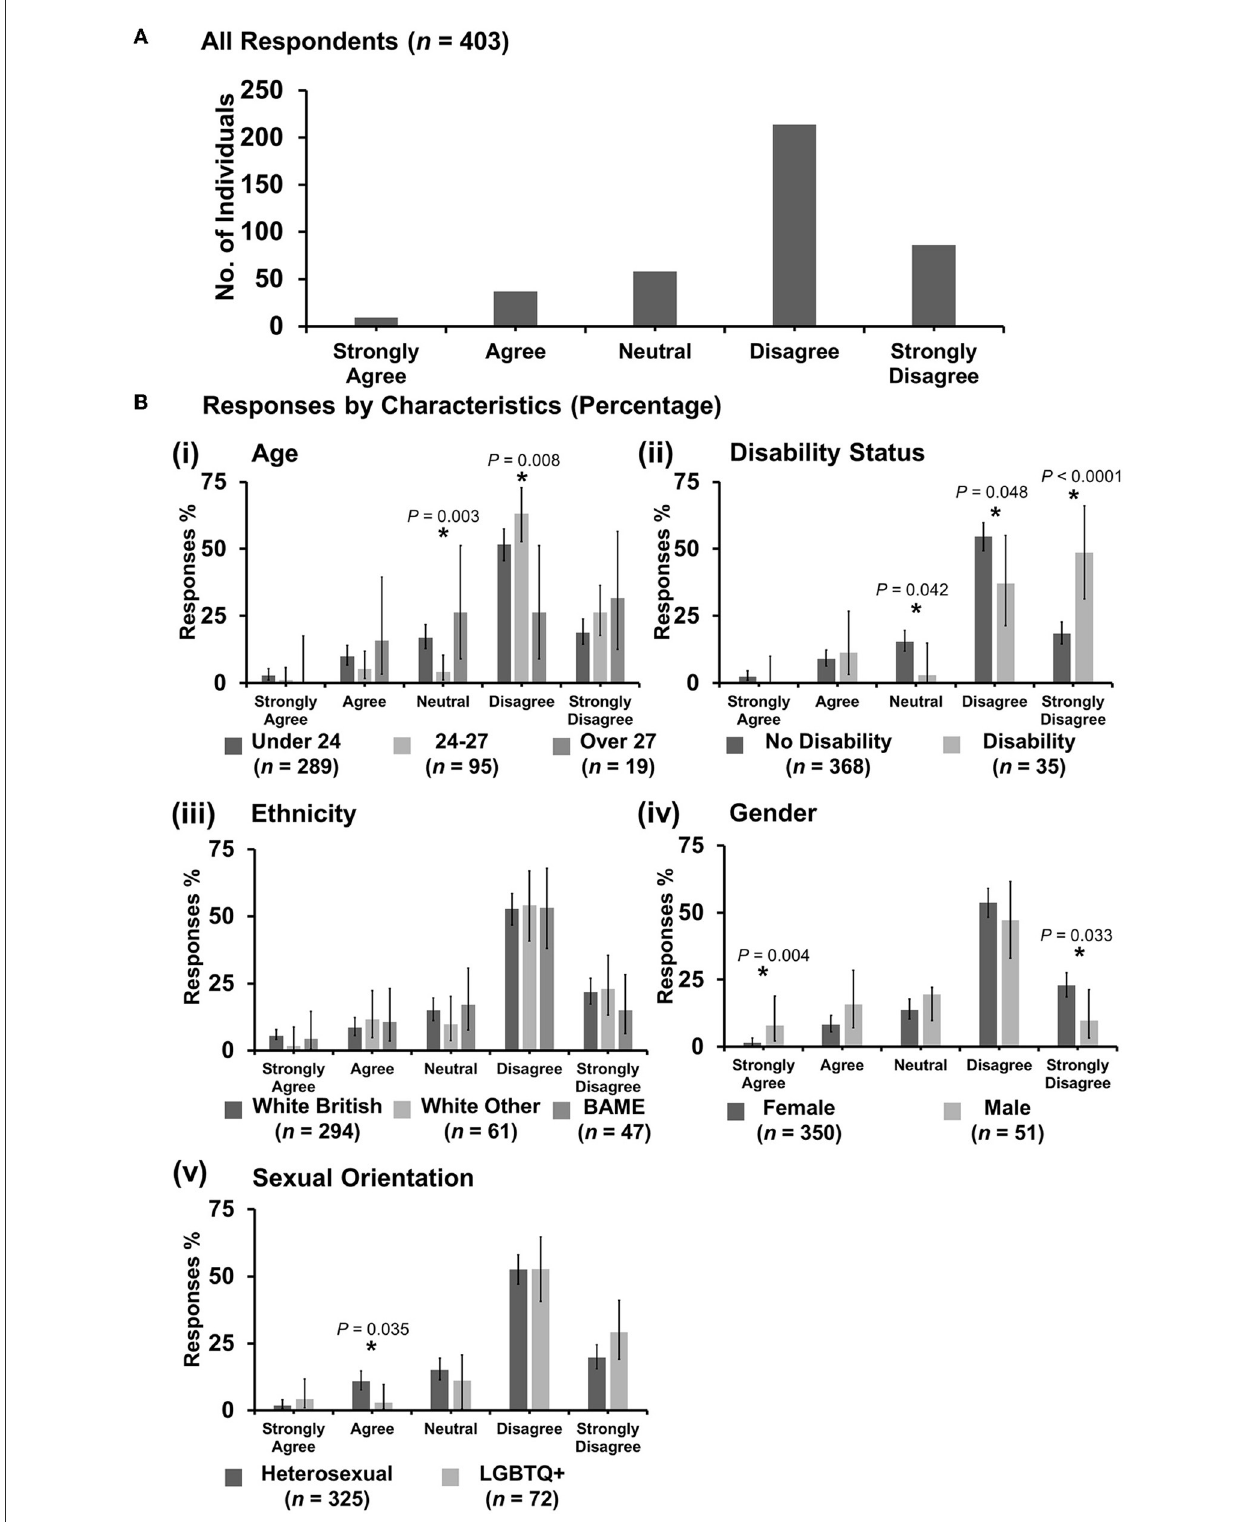
FIGURE9 Likert scale selections for the statement: discrimination against female veterinary students is no longer an issue due to being a majority. (A) Bar graph demonstrating the number of respondents selecting each Likert scale response. [ (B) i–v] Bar graphs demonstrating by percentage proportion the number of responses in each Likert category by the group under the demographic categories of age, disability status, ethnicity, gender, and sexual orientation. Error bars represent 95% confidence intervals calculated by the Binomial “Exact” method. Statistical significance was determined by Pearson’s chi-squared test of association between respondent’s group under category and Likert scale selection. * P <